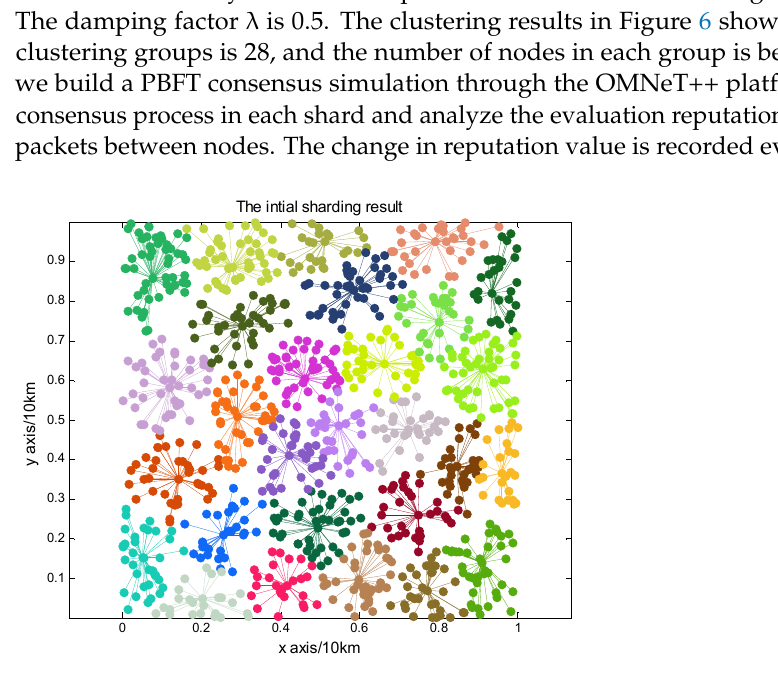
Figure 6. The initial clustering results.